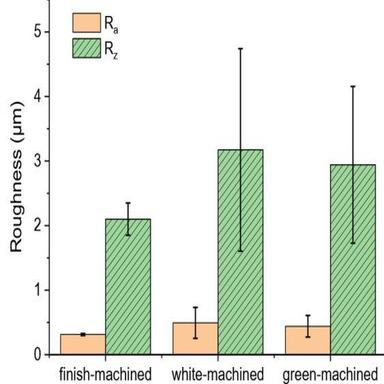
Surface roughness values for the three different surface-finish procedures.